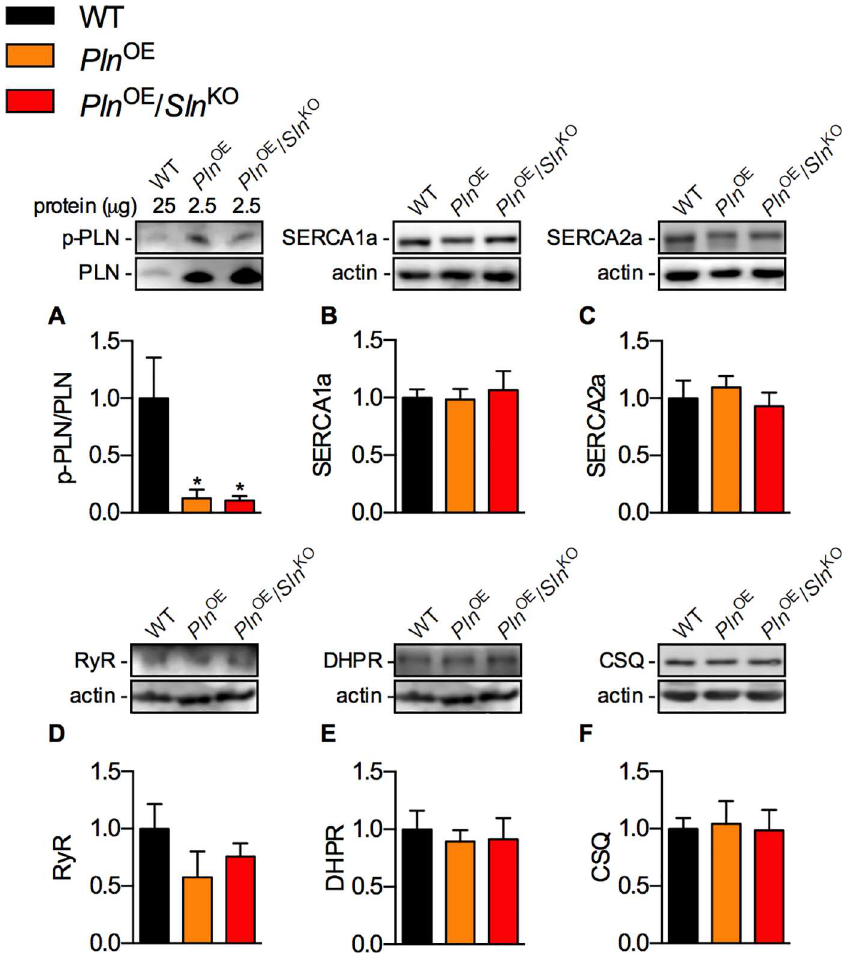
Fig 2. PLN phosphorylation and expressionlevels of other Ca 2+ regulatory proteins. (A) Western blot analysesdemonstrating that monomeric p-PLN/PLN ratio is significantly lower in both Pln OE and Pln OE / Sln KO soleus muscles compared with WT (n = 5–6 per genotype). Western blotting for other major Ca 2+ regulatory proteinsSERCA1a(B, 110 kDa), SERCA2a(C, 110 kDa), RyR (D, 565 kDa), DHPR (E, 170 kDa), and CSQ (F, 63 kDa) did not revealany significantdifferences across genotypes (n = 5–8 per genotype, with a 6 μ g load for all proteins). * Significantly different from WT using a a one-wayANOVA with a Tukey’s post-hoc, p (cid:20) 0.05. All values are means ±